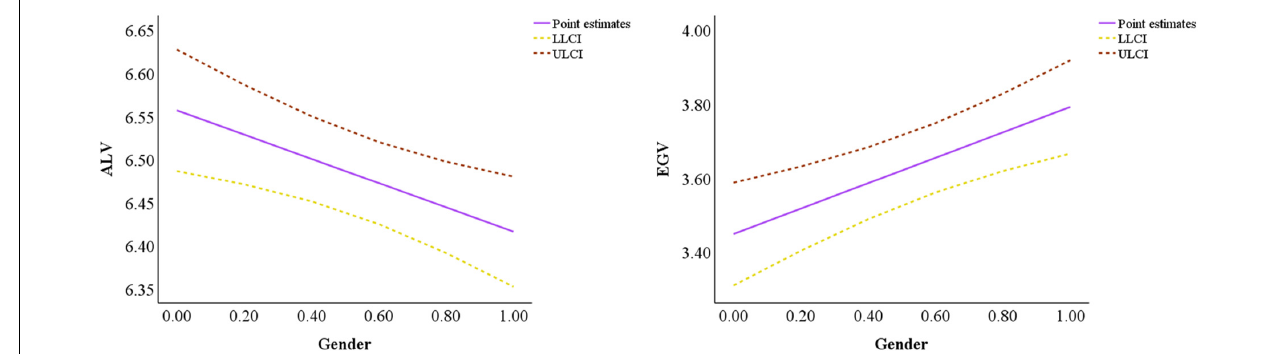
FIGURE 3 | Comparison of the effect of gender on the dual values.